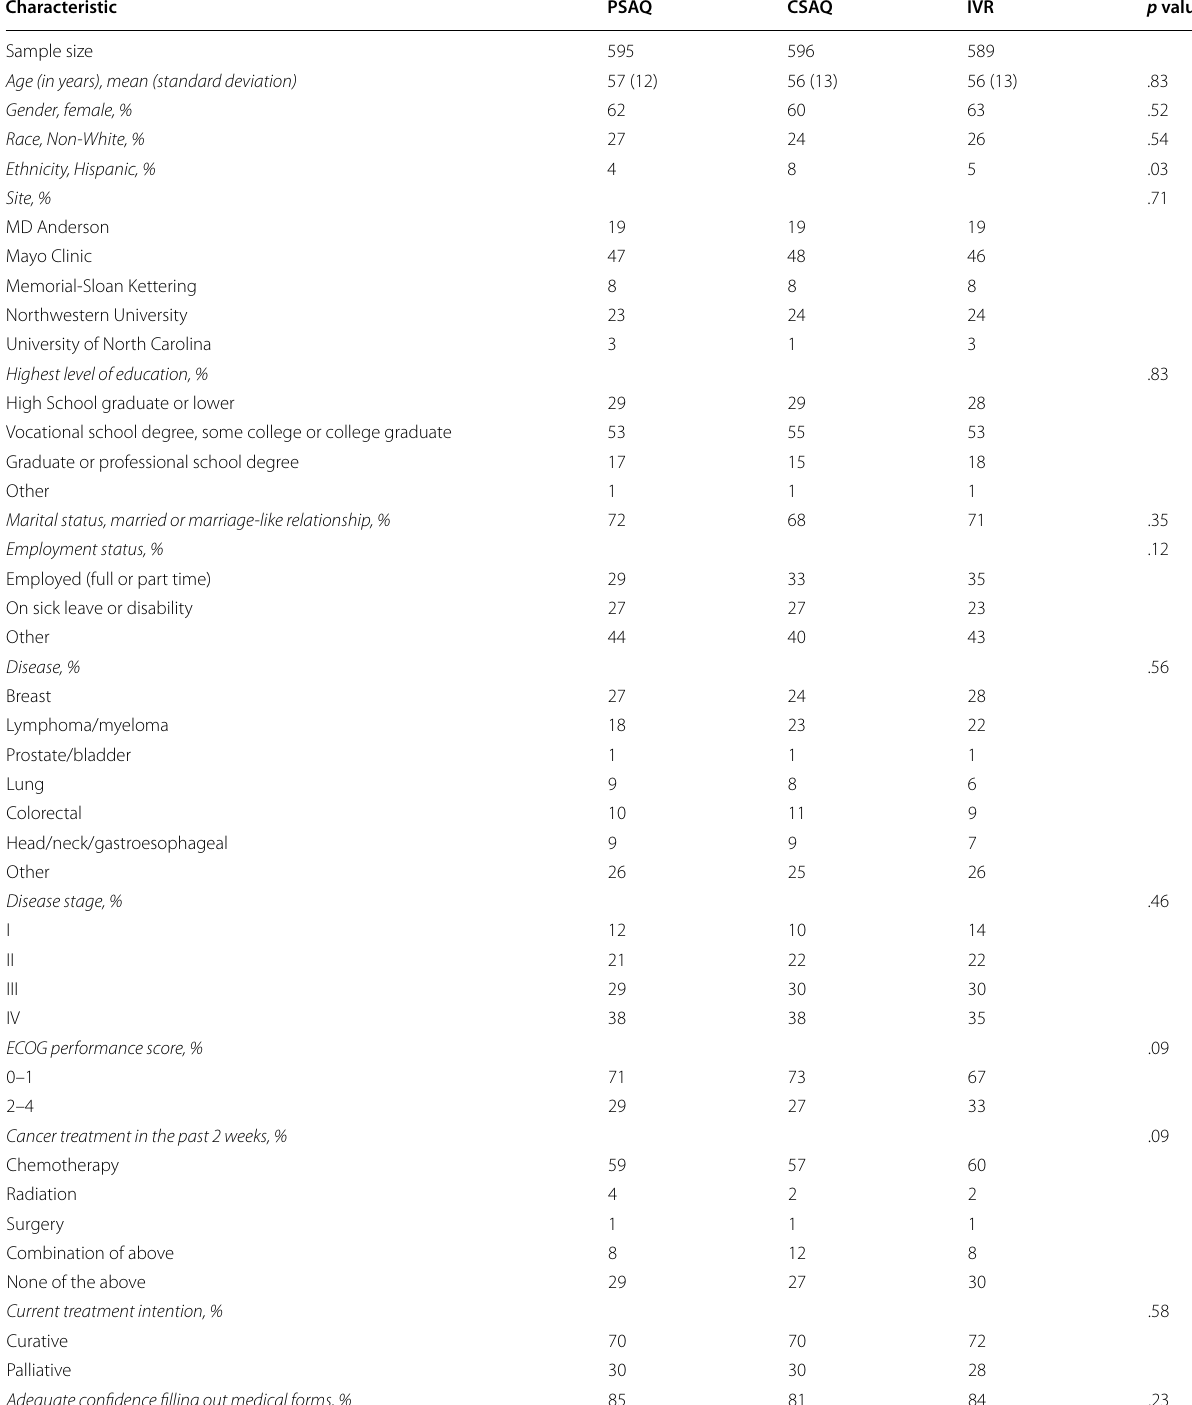
Table 1 Patient characteristics by mode of